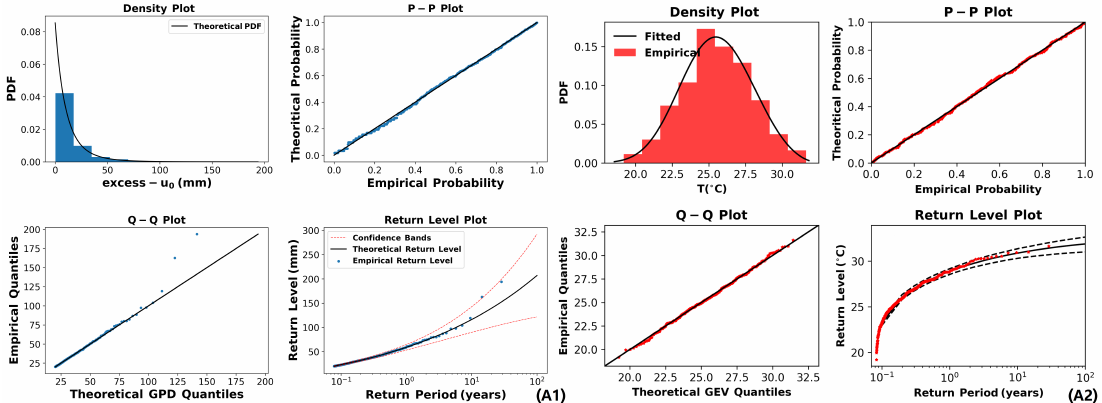
Figure A4. Diagnostic plot for Reggio Calabria station. ( A1 ) Rainfall diagnostic plot. ( A2 ) temperature diagnostic plot.